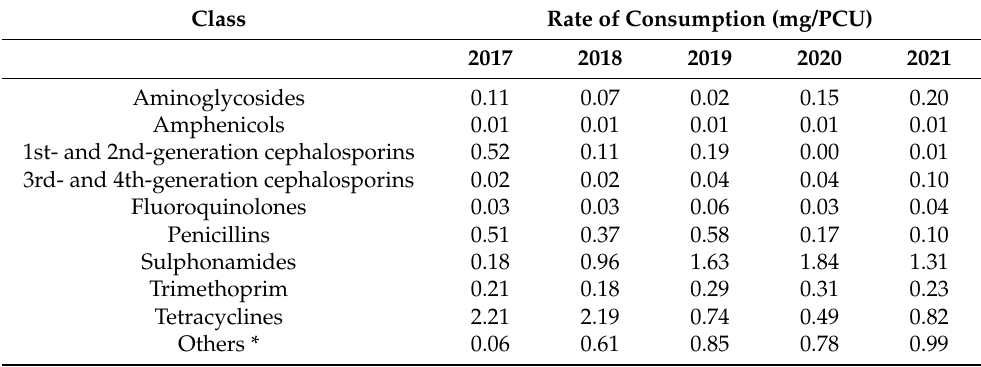
Table 6. Rates of consumption of different classes of antimicrobials in livestock in Bhutan. Class Rate of Consumption (mg/PCU)